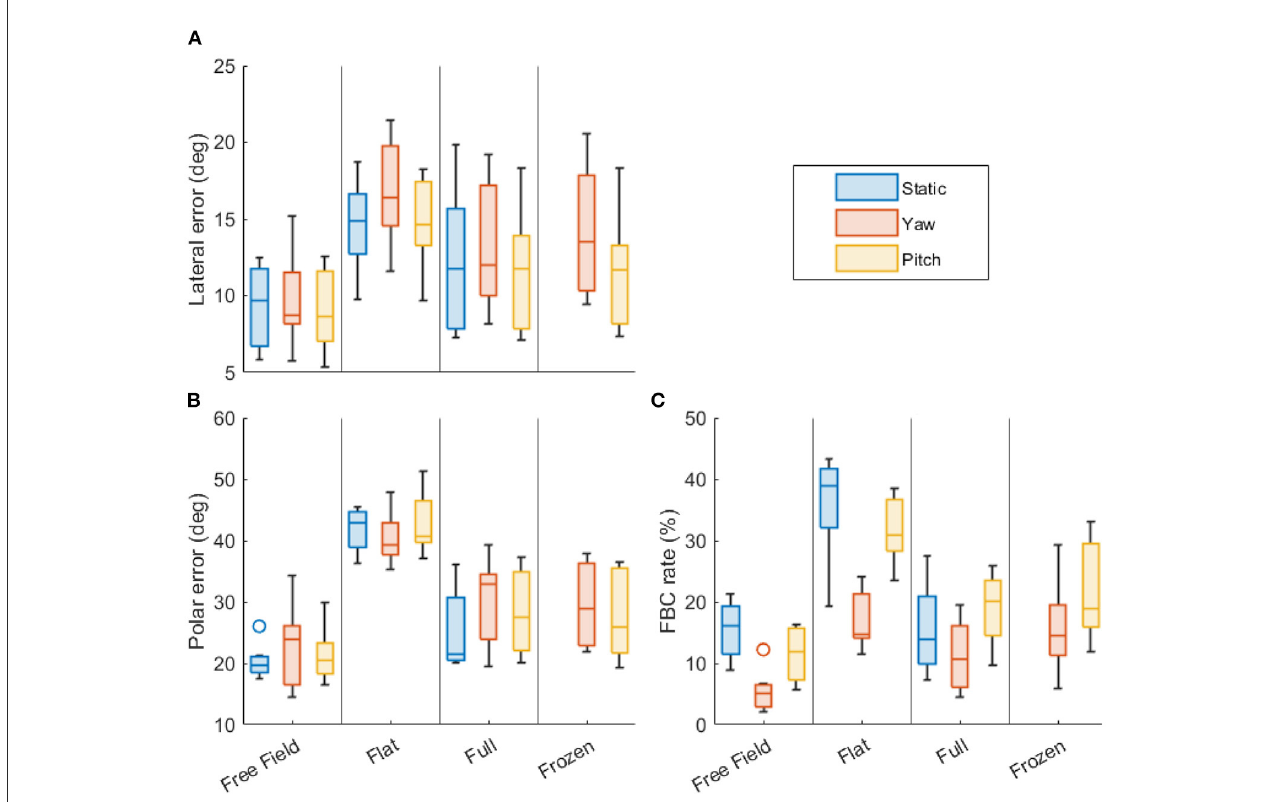
FIGURE3 Localization performance grouped by the available acoustic cues. (A) Lateral precision error (in degrees). (B) Polar precision error (in degrees). (C) Front-back confusion rate (in %). Lower values indicate better performance. Each boxplot shows the statistics of all subjects (median, first and third quartiles, minima and maxima,